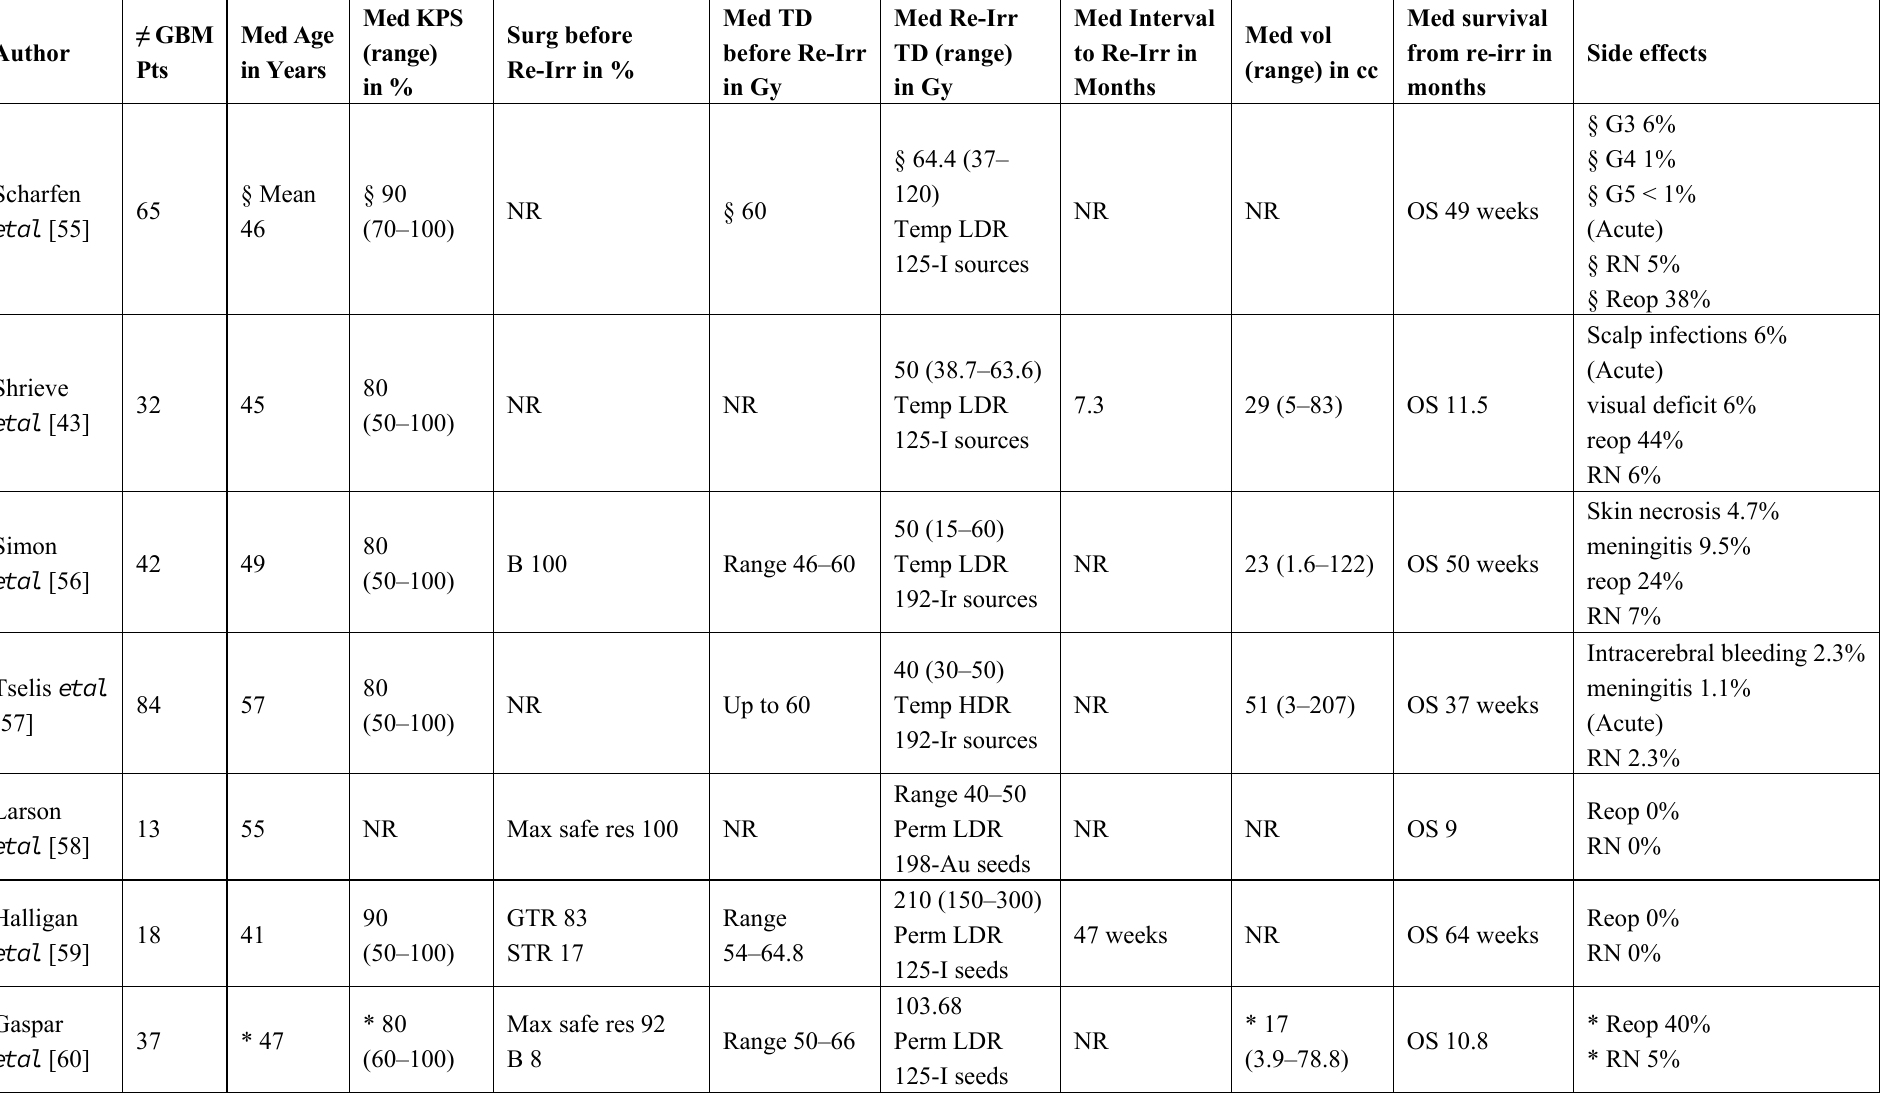
Table 3. Re-irradiation series employing